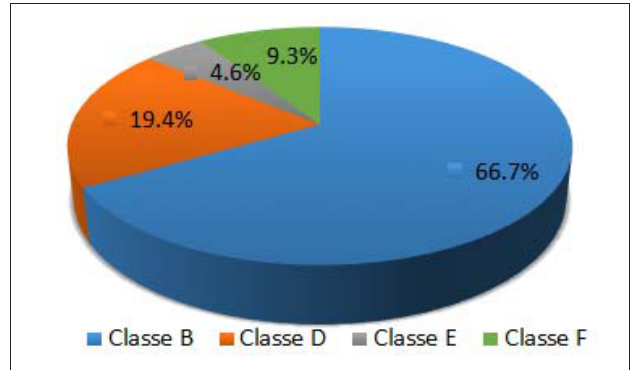
Fig. 4 - Pie chart of the relative frequency (%) of bifid mandibular canals in cone beam computed tomography, according to pathway classification. Class B: mesial or anterior direction; Class D: retromolar direction; Class E: lingual direction; Class F: base of the mandible